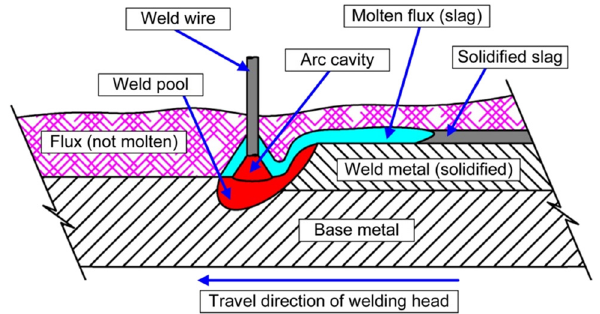
Figure 1: SAW process zone